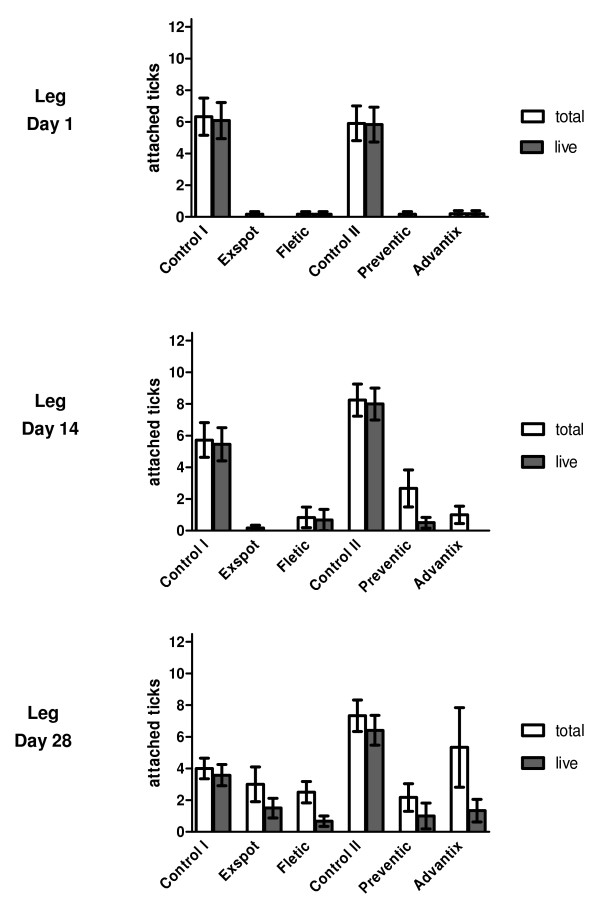
Attached ticks on the leg. Figure showing the attached ticks on the leg over the course of the study. The arithmetic mean of the total of attached ticks (white colour) and of the live attached ticks in particular (dark colour) can be seen for each product and for their particular control groups. The standard error of mean is included.